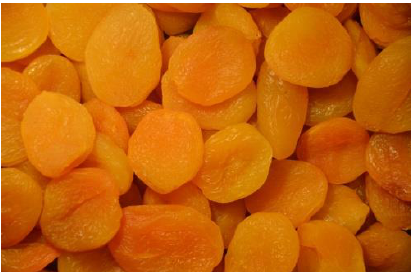
Figure 8a. Apricot dried fruits